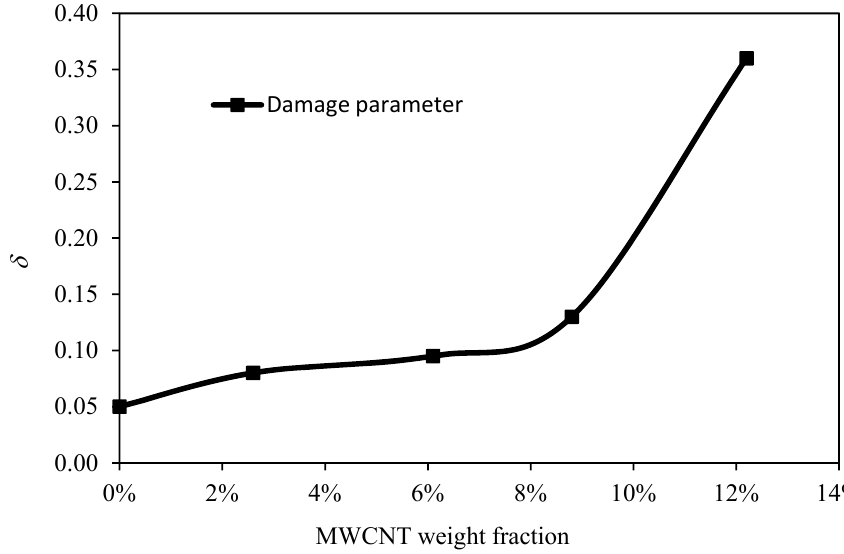
Figure 4. Softening parameter behavior, δ , as a function of the material weight fraction of MWCNT.